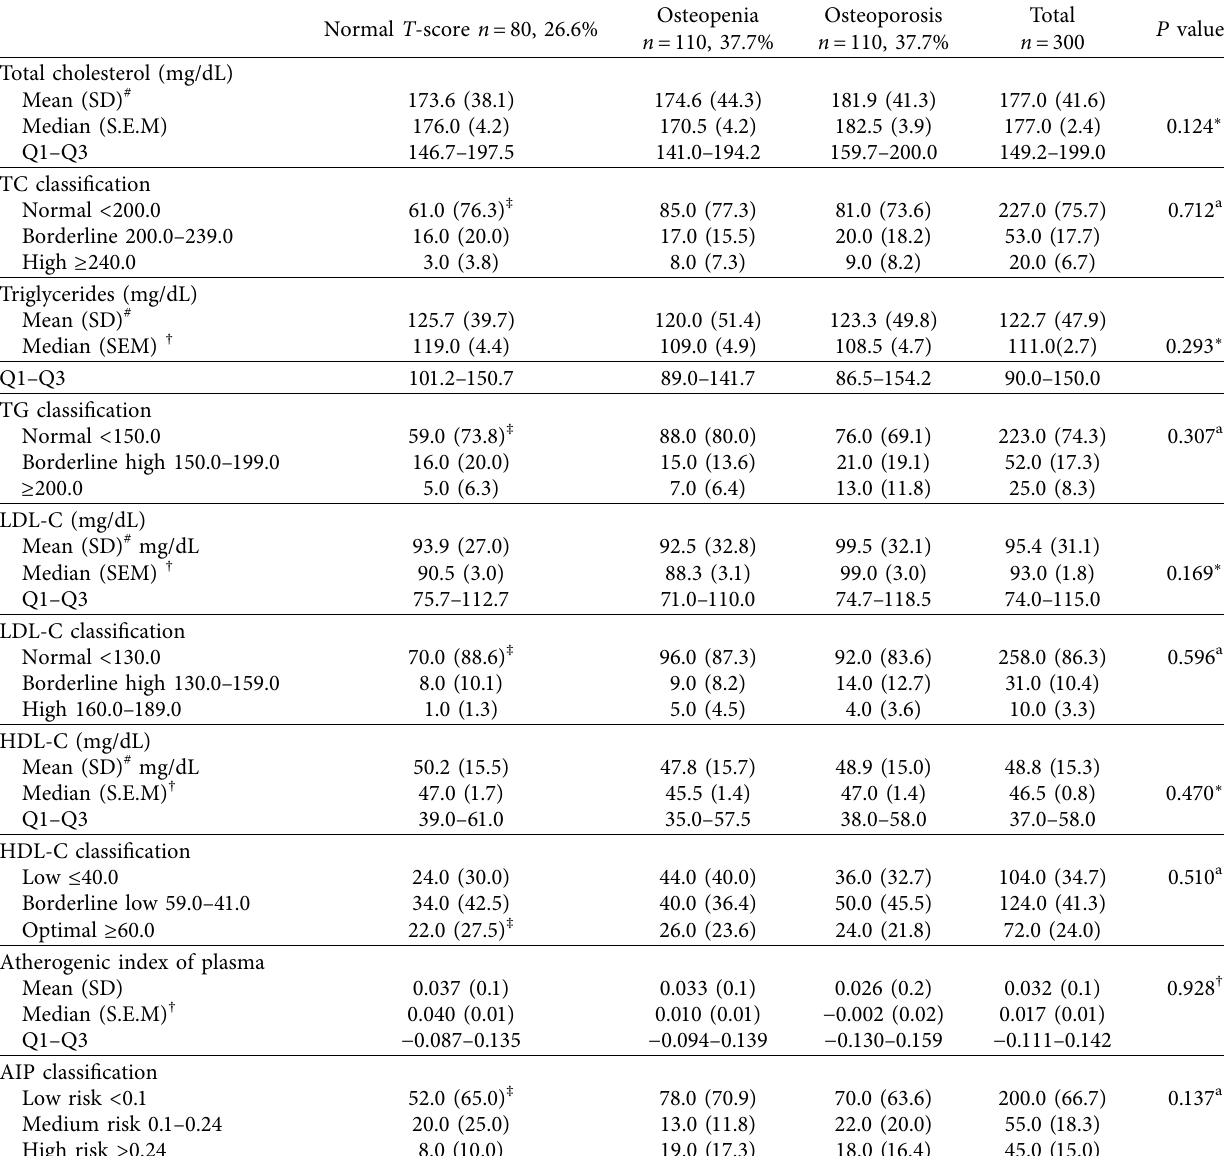
Table 2: Lipid profile of normal T -score, osteopenic, and osteoporotic postmenopausal Sudanese